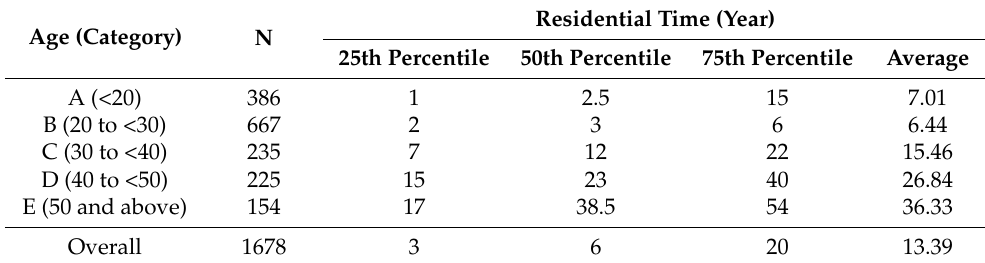
Table 4. The relationship between age and residential